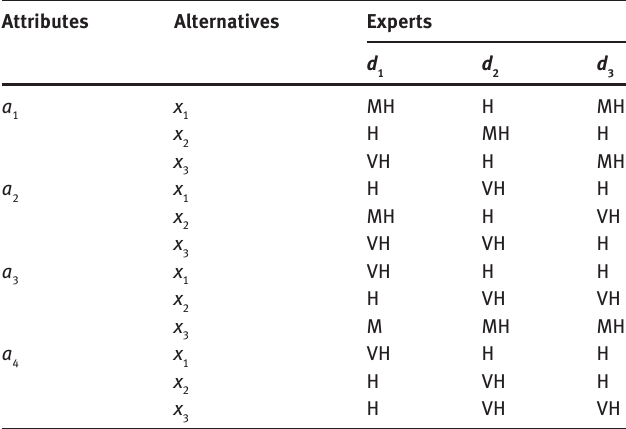
Table 4. Normalized Decision Matrix Given by Expert d